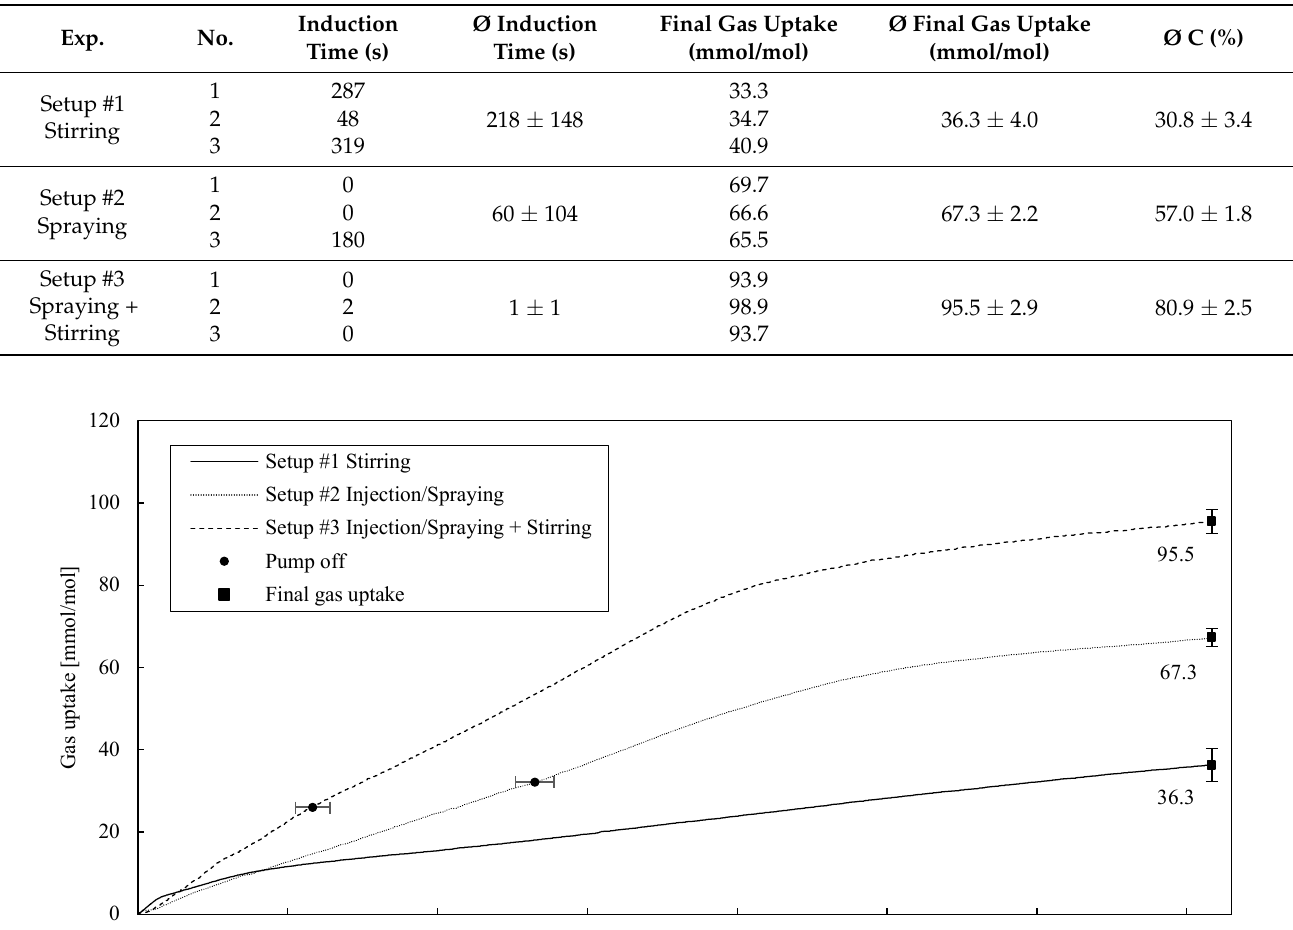
Table 1. Experimental results for three different reactor setups.